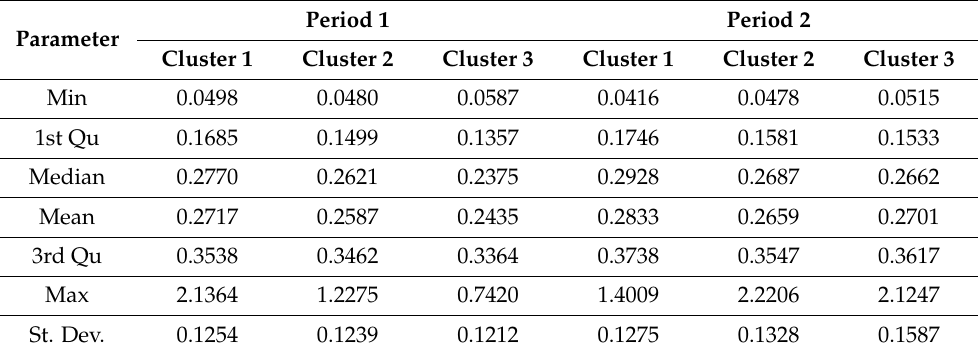
Table 12. Descriptive statistics of the power-line flicker in phase L3 at the tested measuring